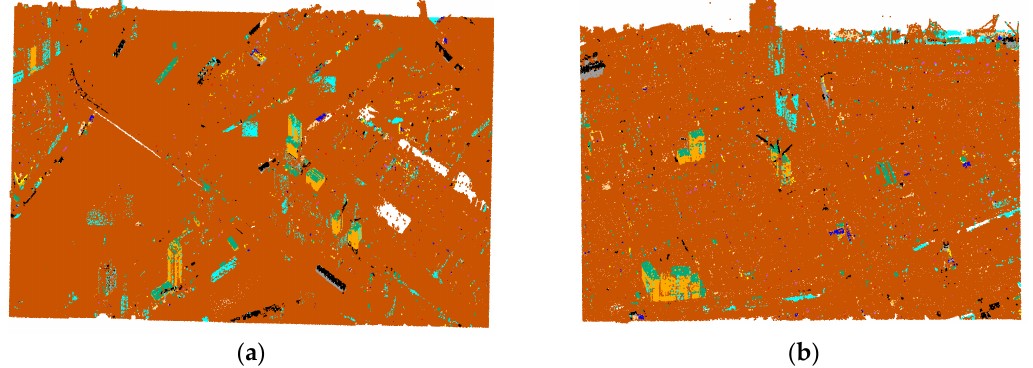
Figure 17. Classification of change in the test areas. ( a ) 2008 vs . 2010, ( b )2010 vs . 2012.